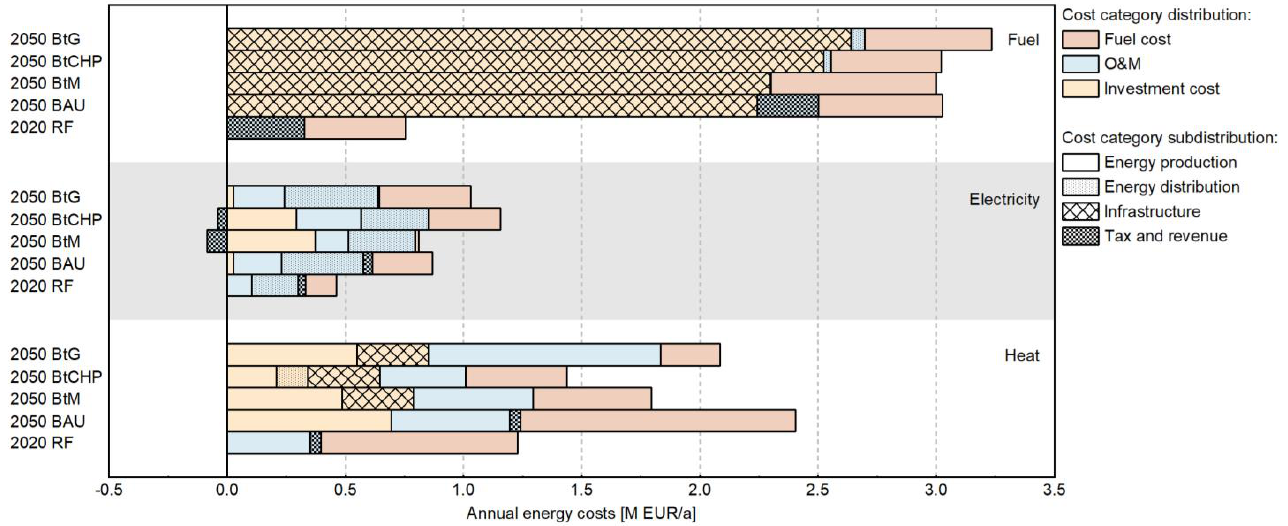
Figure 10. Comparison of annual energy costs of the reference case (2020) with assumed scenarios (2050).